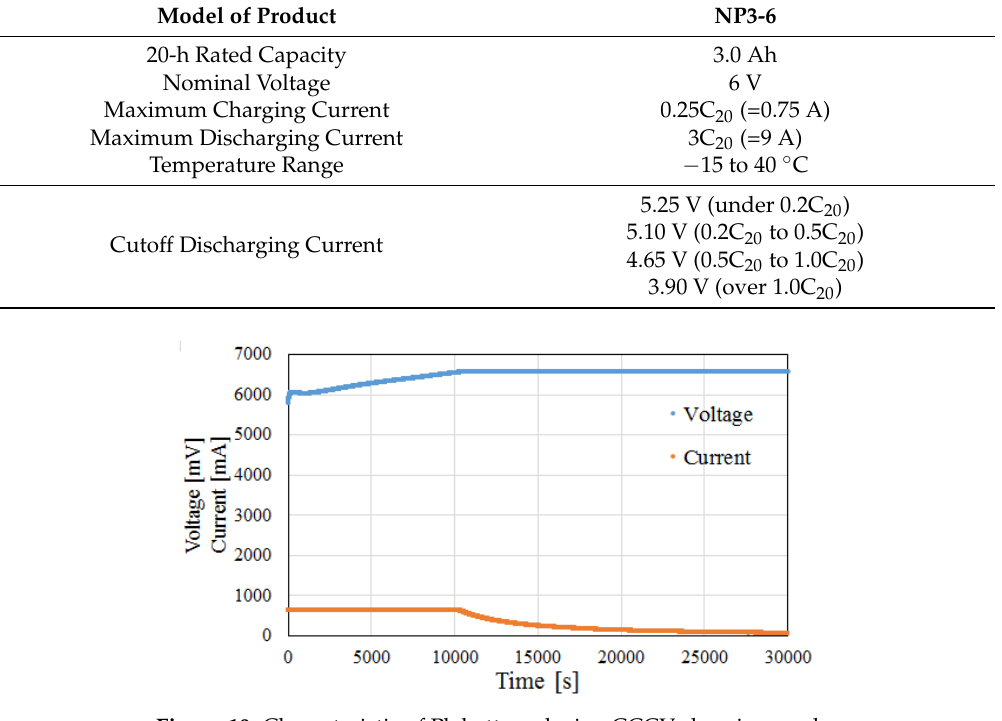
Figure 10. Characteristic of Pb battery during CCCV charging mode.